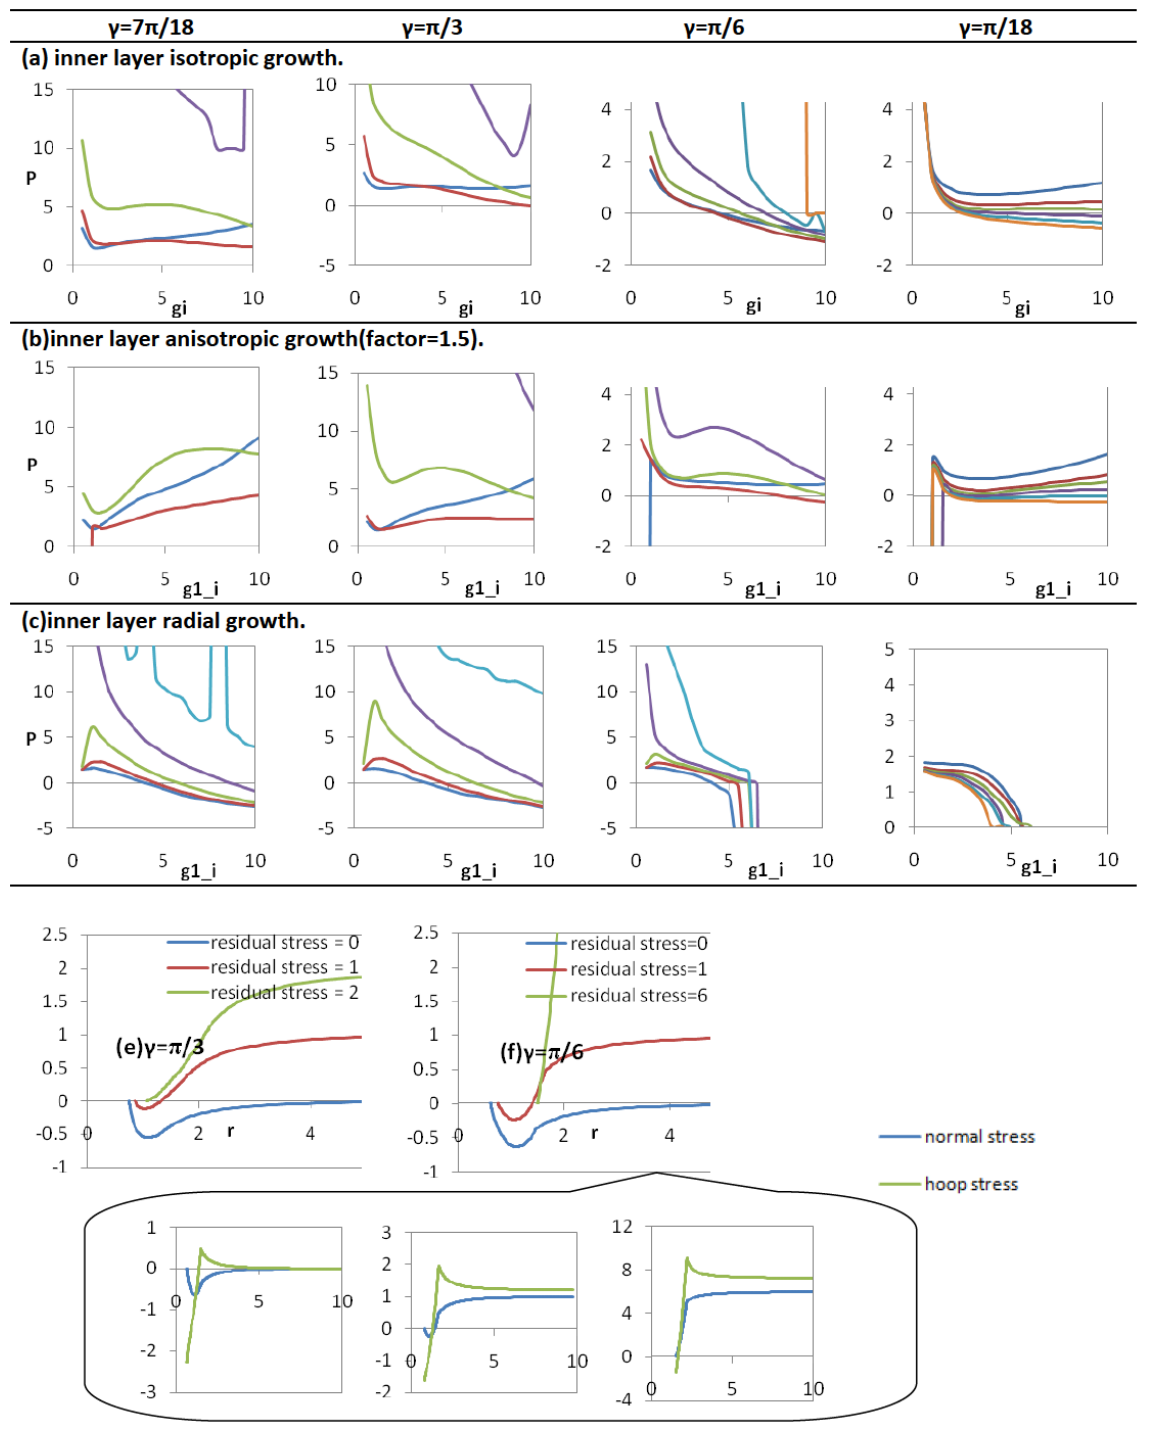
Figure 11: Wound edge instability in various growth scenarios. µ i = µ o (a) Inner layer isotropic growth. Enforced circular outer boundary = 1.5 ). Enforced circular outer boundary simulating loose simulating loose skin. (b) Inner layer anisotropic growth (anisotropic factor gθ gr skin. (c) Inner layer radial growth. Enforced circular outer boundary. (d-e) Inner layer radial growth. Normal stress plotted against radial position for different skin residual stress level. Inset: radial and hoop stress plotted together for each skin residual stress